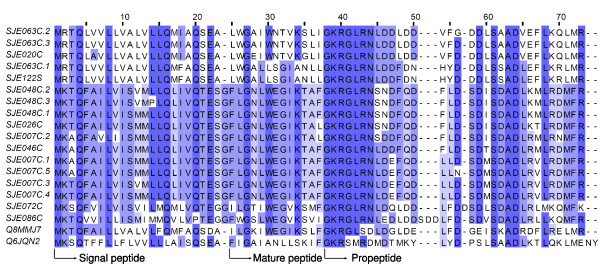
Sequence alignment of cytolytic peptides. SJEs are clusters from this work. Q8MMJ7 is cytotoxic linear peptide IsCT from the scorpion Opisthacanthus madagascariensis, and Q6JQN2 is BmKn2 from Mesobuthus martensii.